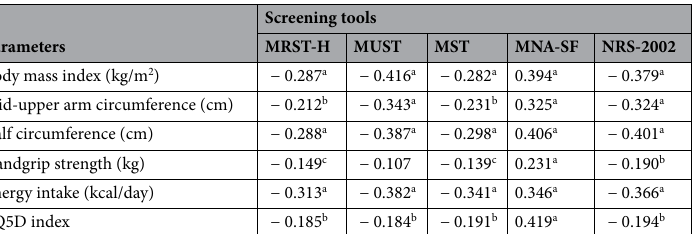
Table 7. Correlations of different malnutrition screening tools with anthropometric, dietary and health- related quality of life in non-elderly group. a P < 0.001; b P < 0.01; c P < 0.05; Spearman’s rank correlation